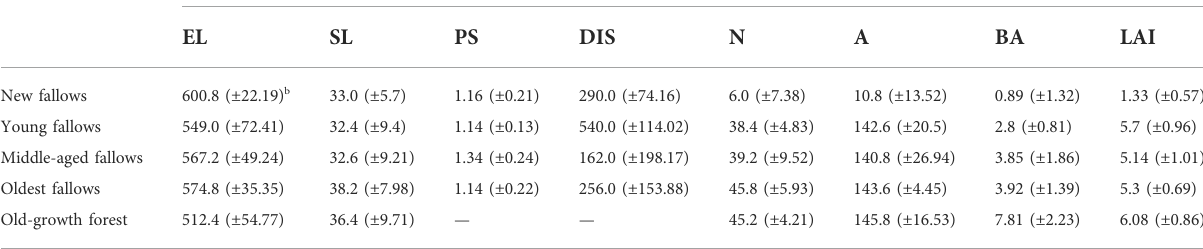
TABLE 1 Environmental attributes of our study sites on Leyte Island, the Philippines.